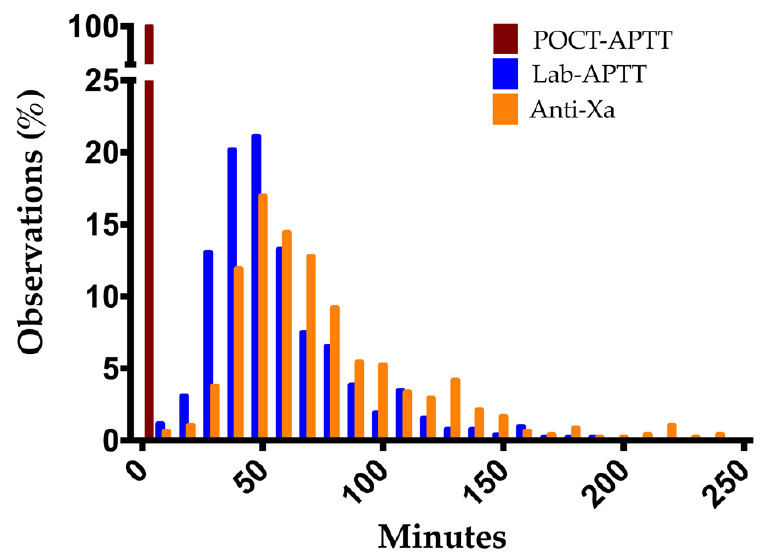
Figure 6. Turnaround times from sample collection to delivery results for POCT-APTT (brown), lab-APTT (blue) and anti-Xa (orange).